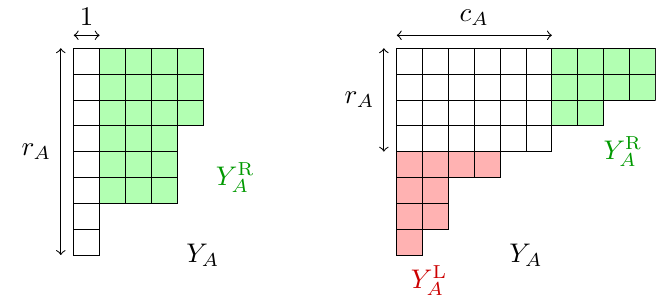
~Y with exactly r A 2 A rows, which can be with at most r A rows. The second (cid:12)gure shows A c A (such that r A c A = 2) (cid:2) (cid:0) (cid:0) and Y R having at most c A columns and r A rows A A ) _ has at most c A rows. When ~ n = ~ 0, we return to the A